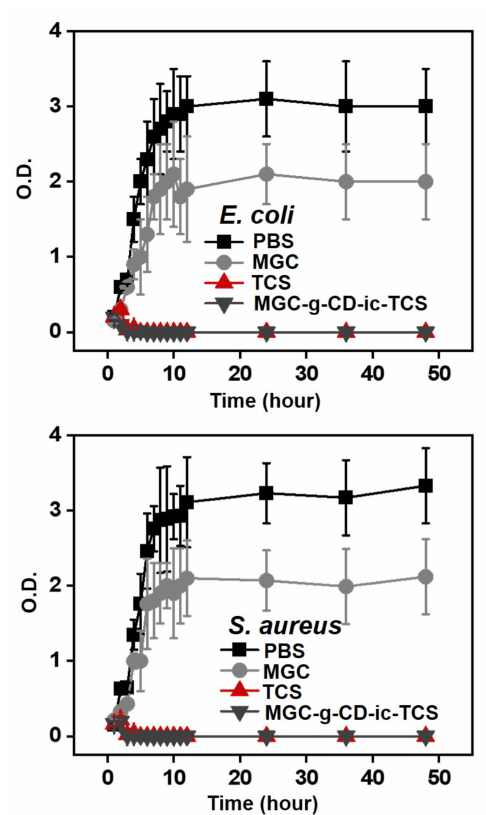
Figure 5. Antibacterial activity of MGC-g-CD-ic-TCS on E. coli and S. aureus , compared to PBS, MGC, and TCS. This test was performed in triplicate ( n =